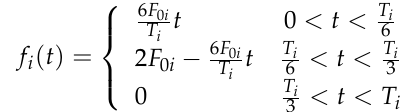
The ice force function throughout one cycle is defined by: